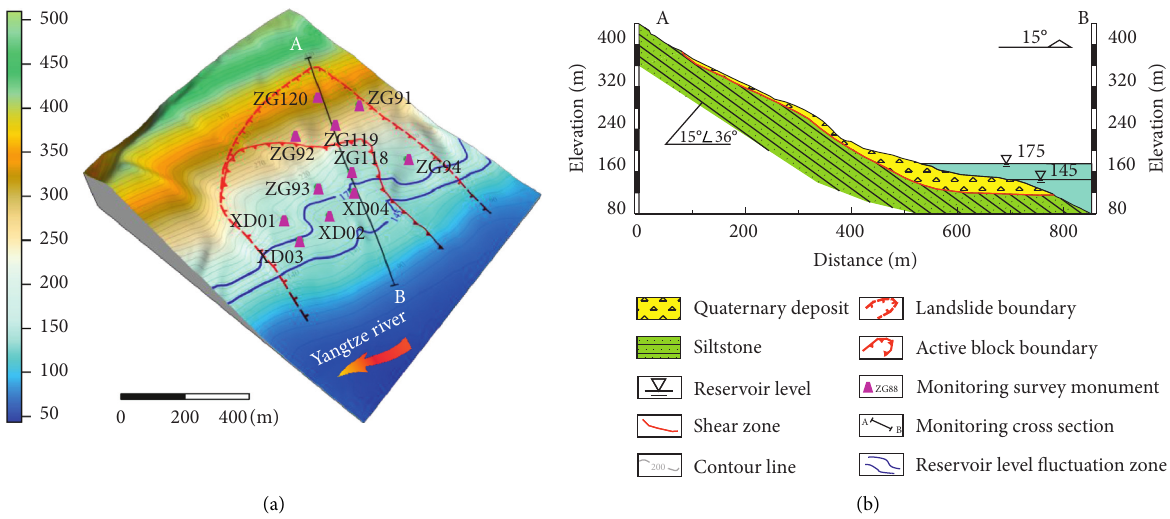
Figure 2: (a) Three-dimensional topographic contour map of the Baishuihe landslide. (b) Engineering geological cross section (A-B) of the Baishuihe